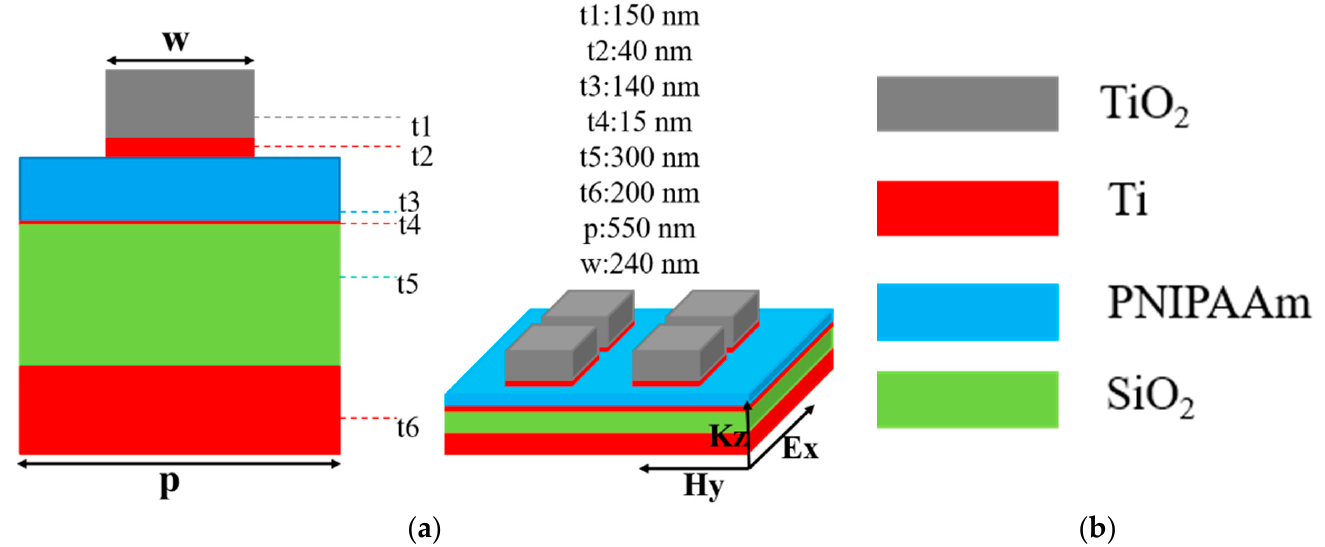
Figure 1. ( a ) Side view for the unit cell of the designed UWB absorber and the stereogram image represented a small region of the designed UWB absorber consisting of the symmetric arrangements of a two-layer square cubes stacking on the four-layer continuous plane films, ( b ) the colors used to represent different materials.